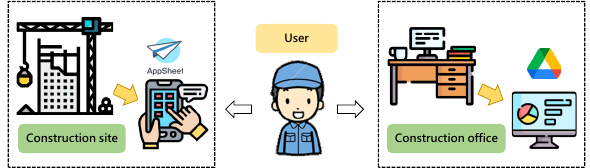
Figure 12. Platform